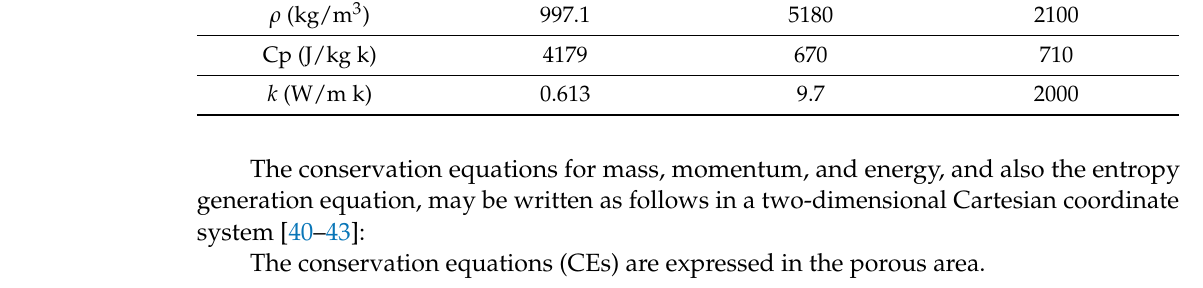
𝑷𝒖𝒓𝒆 𝑾𝒂𝒕𝒆𝒓 Fe 3 O 4 𝑴𝑾𝑪𝑵𝑻 Pure Water Fe 3 O 4 MWCNT 𝜌 (kg/m 3 ) ρ (kg/m 3 ) 997.1 5180 4179